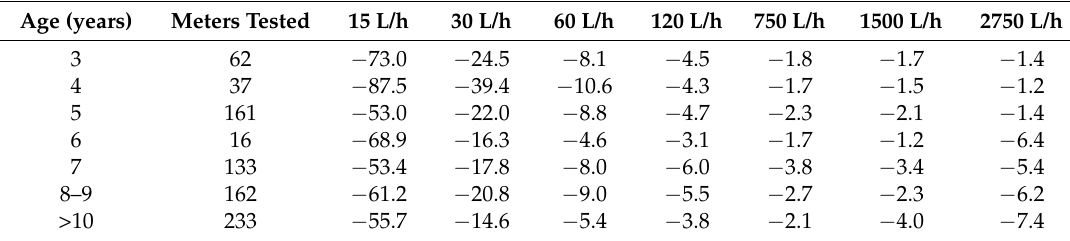
Table 4. The average error of indication (%) of meter type M_2 classified by age.